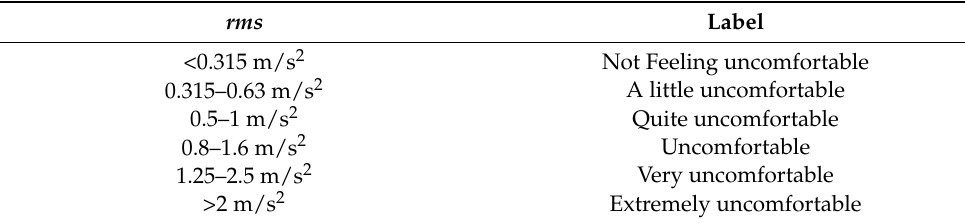
Table 2. Vibration limit (ISO